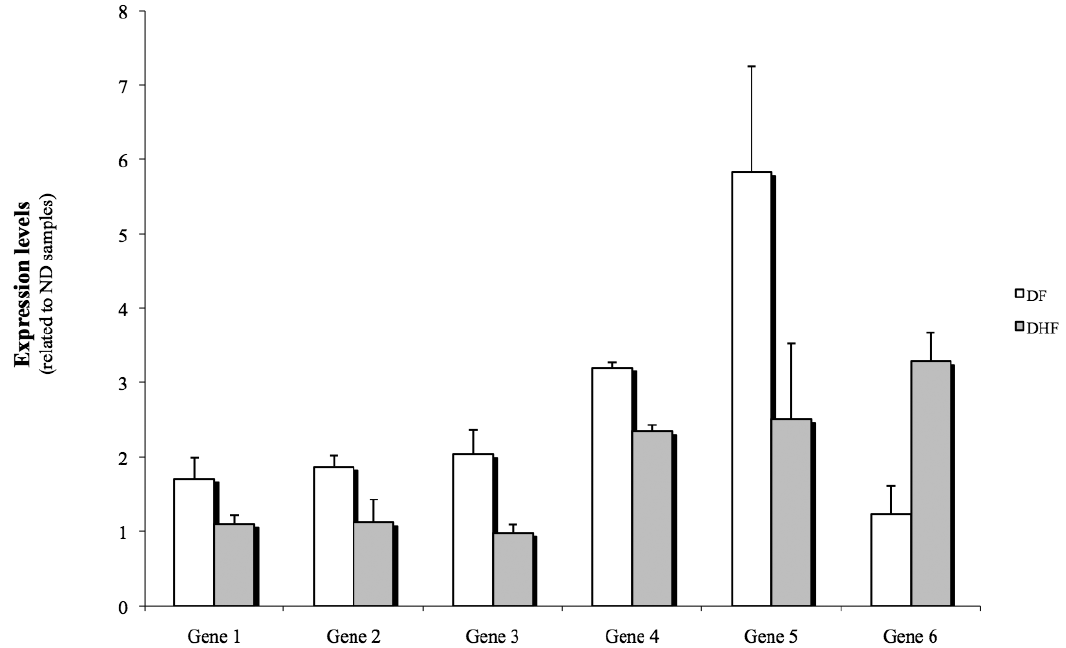
Fig. 3 – Expression levels of six genes in samples of patients with different clinical forms of dengue. The amount of mRNA of each tested gene was measured by qPCR assays using pools of eight DF/DFC or eight DHF cDNA samples as template. Expression levels are related to values obtained from pools of five ND samples. All samples were tested in triplicates. Data representative of three experiments to genes 1, 3, 4 and 5 and two experiments to genes 2 and 6. All the differences were statistically significant (p <